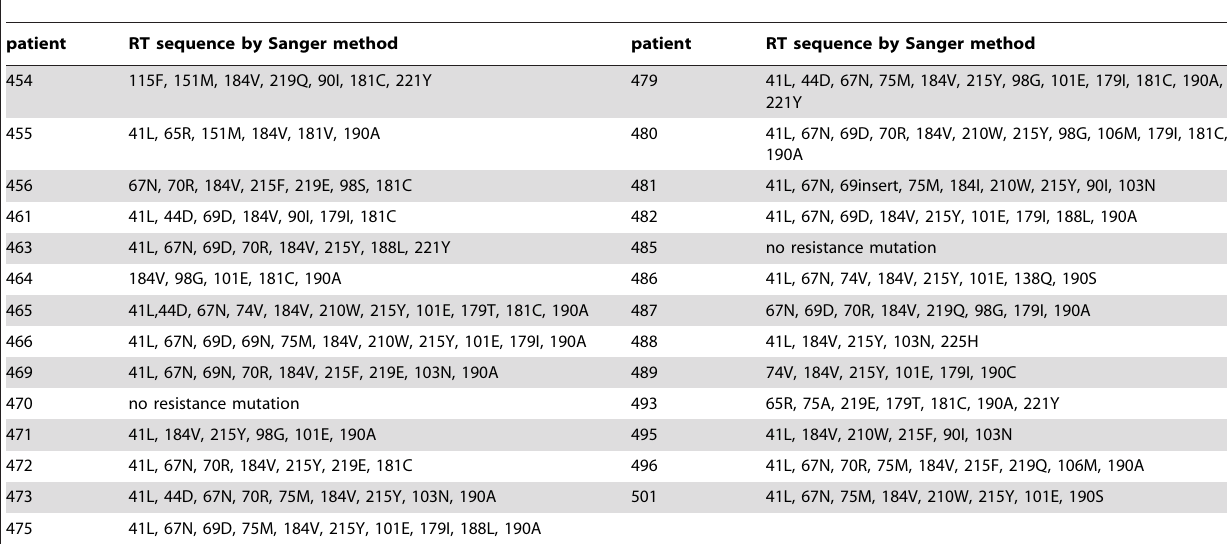
Table 3. RT bulk sequences of 27 subtype C HIV-1 isolates failing on first line.